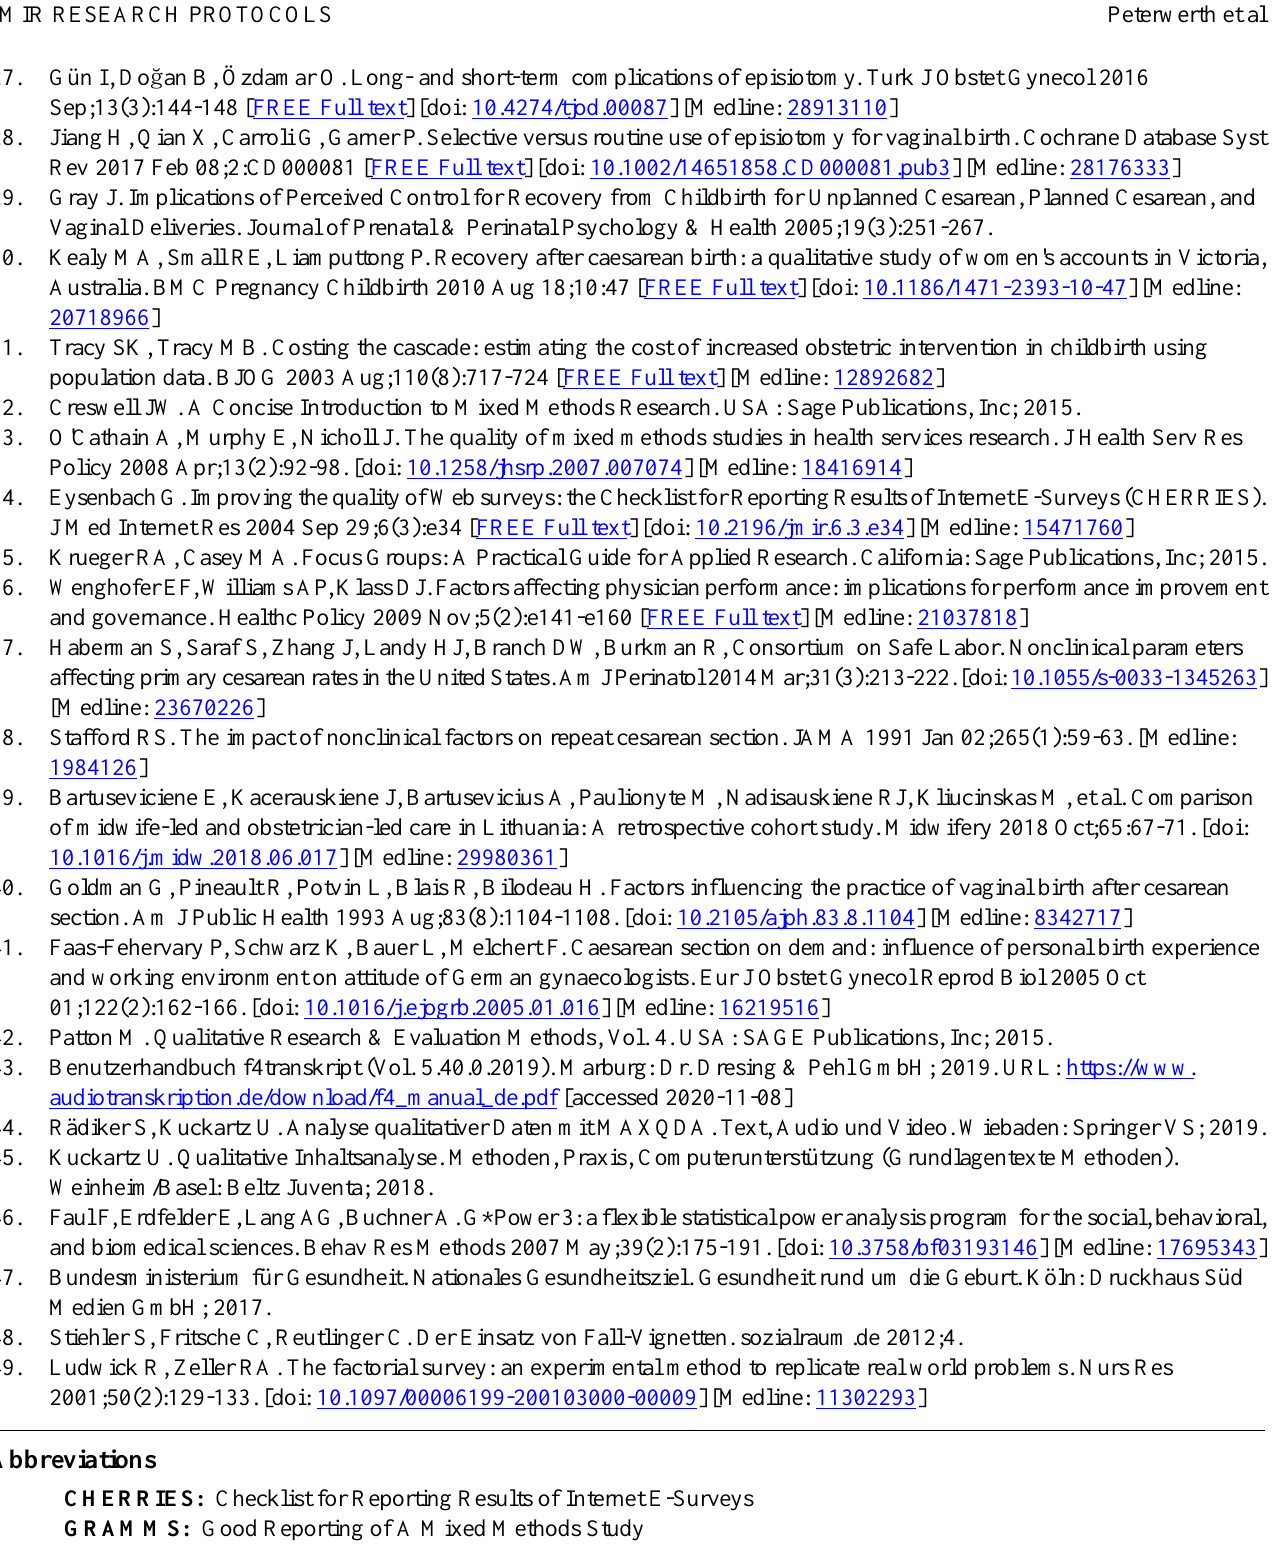
CHERRIES: Checklist for Reporting Results of Internet E-Surveys GRAMMS: Good Reporting of A Mixed Methods